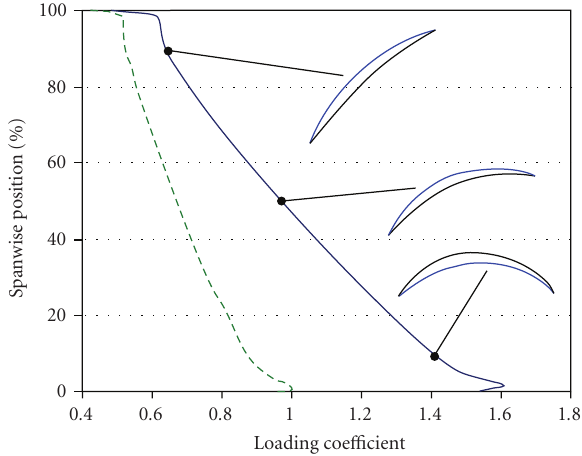
Figure 9: Loading coe ffi cient distribution and cross sections for the blade used in Section 3.2 (solid line) and the blade having a pressure a ratio of 1.175 (dashed line).